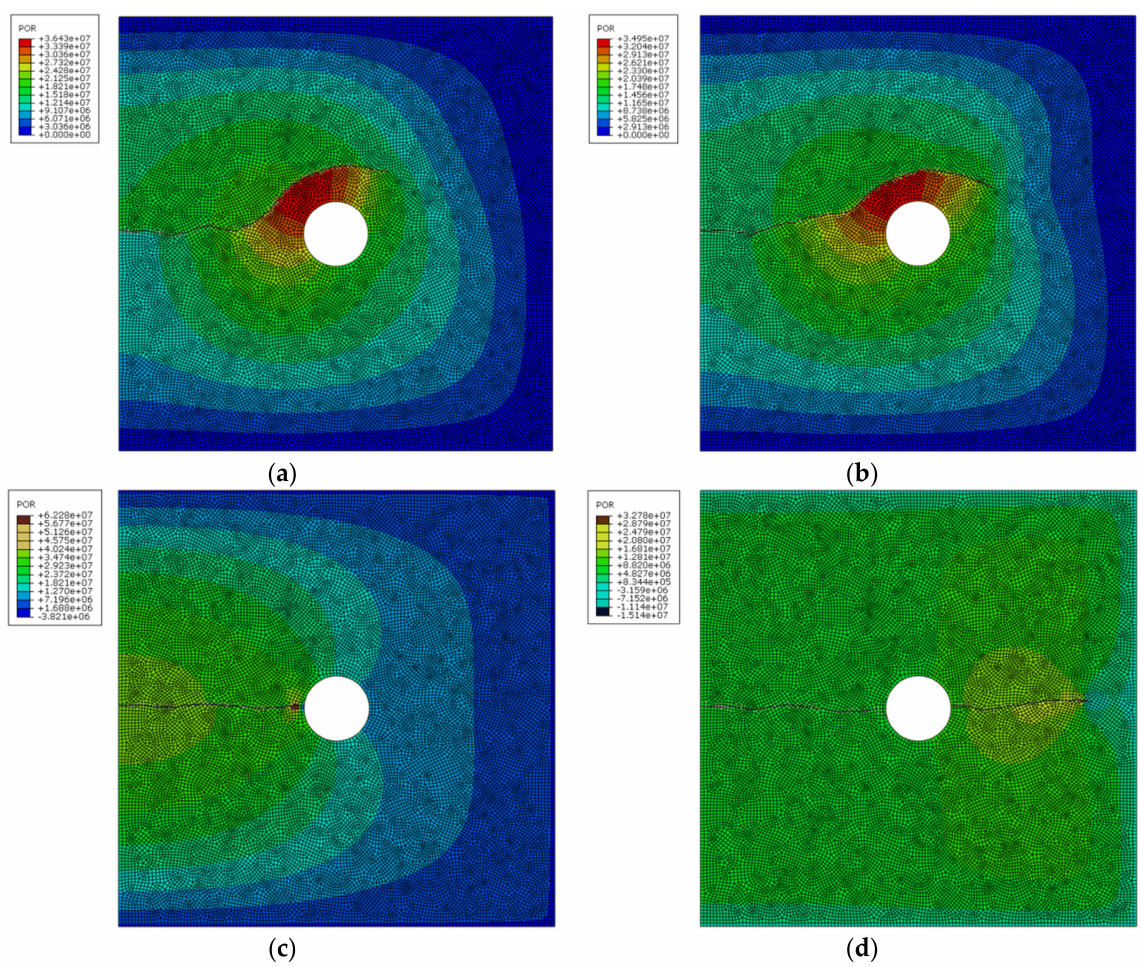
Figure 14. Cloud diagram of fracture propagation under different horizontal stress difference: ( a ) ∆ σ = 5 MPa; ( b ) ∆ σ = 10 MPa; ( c ) ∆ σ = 15 MPa; and ( d ) ∆ σ = 20 MPa. (POR is the pore pressure. With the color gradually changing from red to blue, the pore pressure